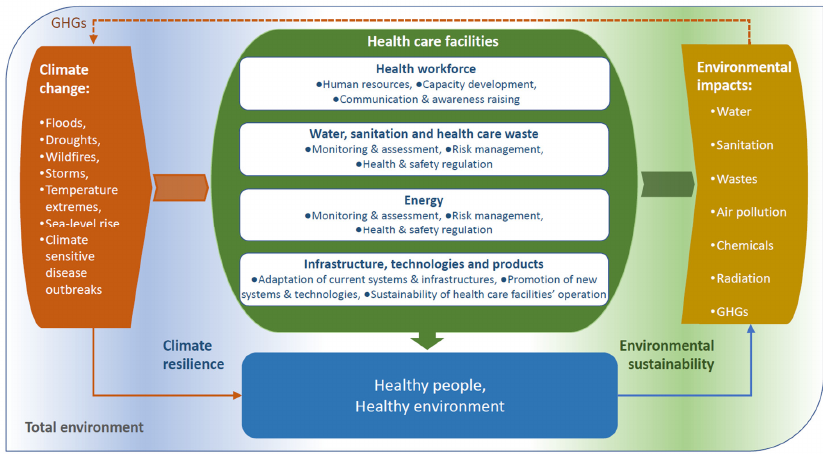
Figure 3. Framework for building climate resilient and environmentally sustainable health care facilities.